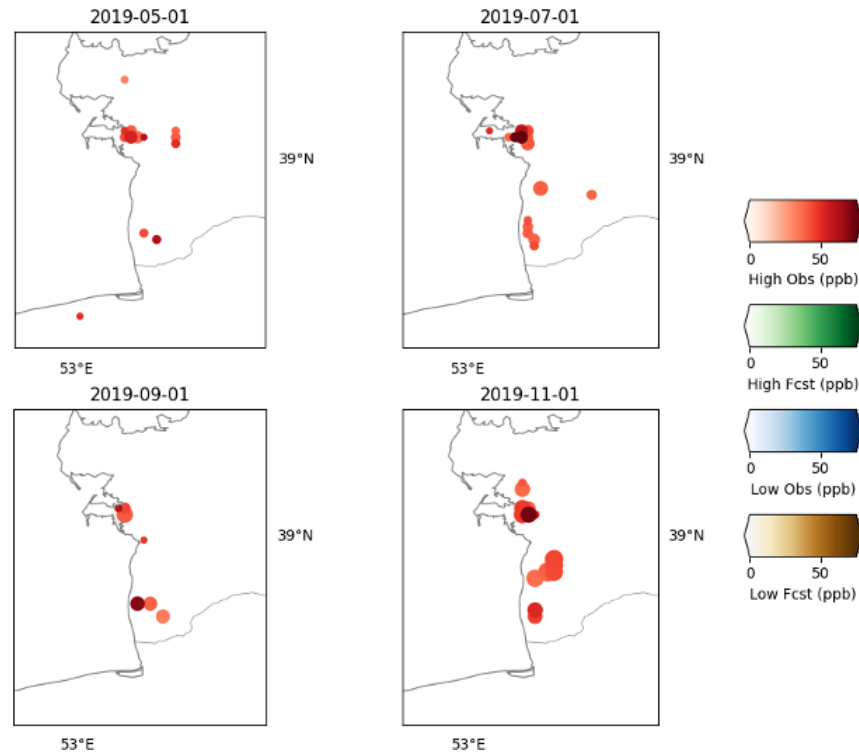
Figure 11. Outlier detection and classification over Turkmenistan. Dates indicate the end date of the 30d time